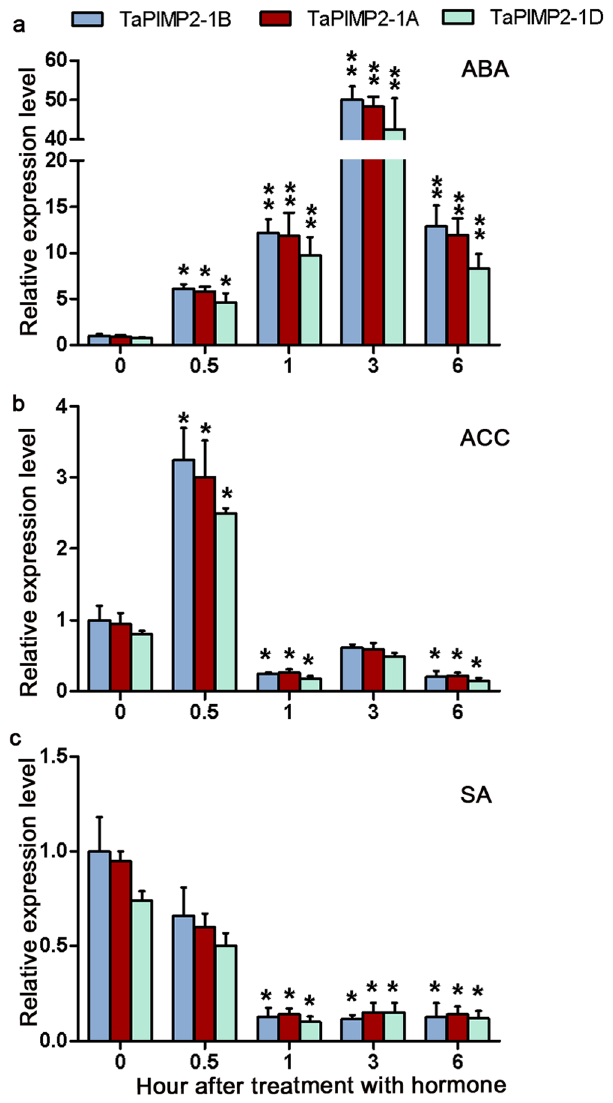
Figure 4. Transcriptional patterns of TaPIMP 2 homoeologous members after treatment with hormones. The wheat cultivar Yangmai 16 plants were sprayed with abscisic acid (ABA), 1-aminocyclopropane-1-carboxylic acid (ACC, precursor of ethylene), salycilic acid (SA), or Tween-20 solution. The transcriptional level of TaPIMP2 - 1B from the wheat plants treated with Tween-20 was used as control. The mean and standard deviation were calculated using data from three independent biological replicates. Asterisks indicate statistically significant differences. (Student’s t - test : * P < 0.05, ** P <